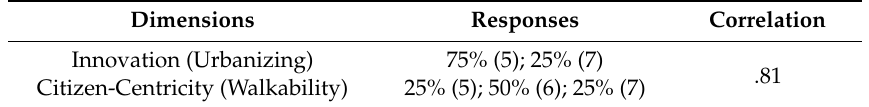
Table 4. Responses and correlation for innovation and citizen-centricity as dimensions of